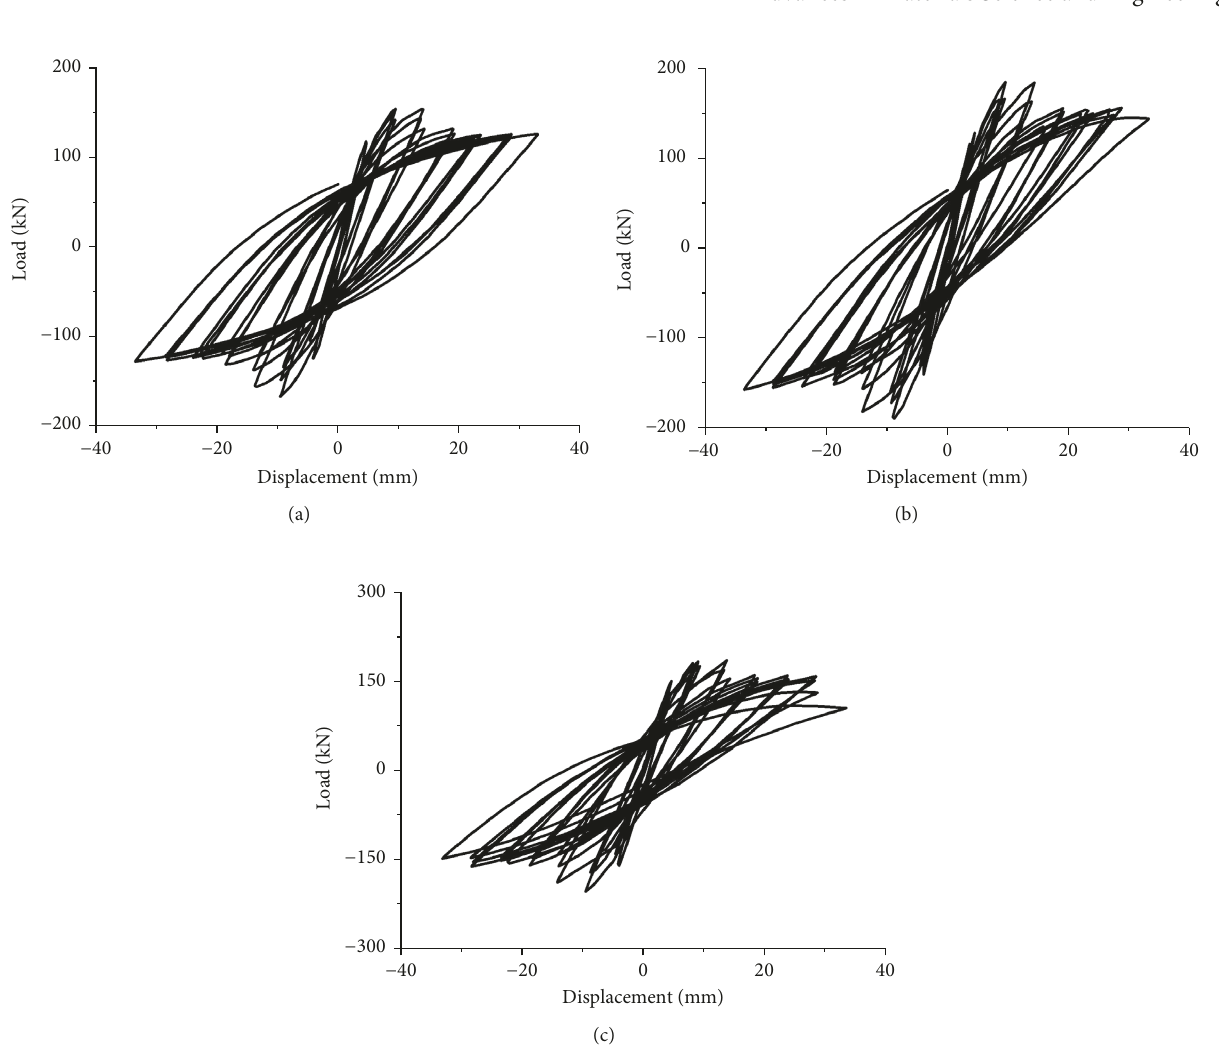
Figure 9: Load-displacement hysteresis curves of specimens: (a) L30 × 3; (b) L30 × 5; (c) L30 × 7. Table 4: Bearing capacities of the